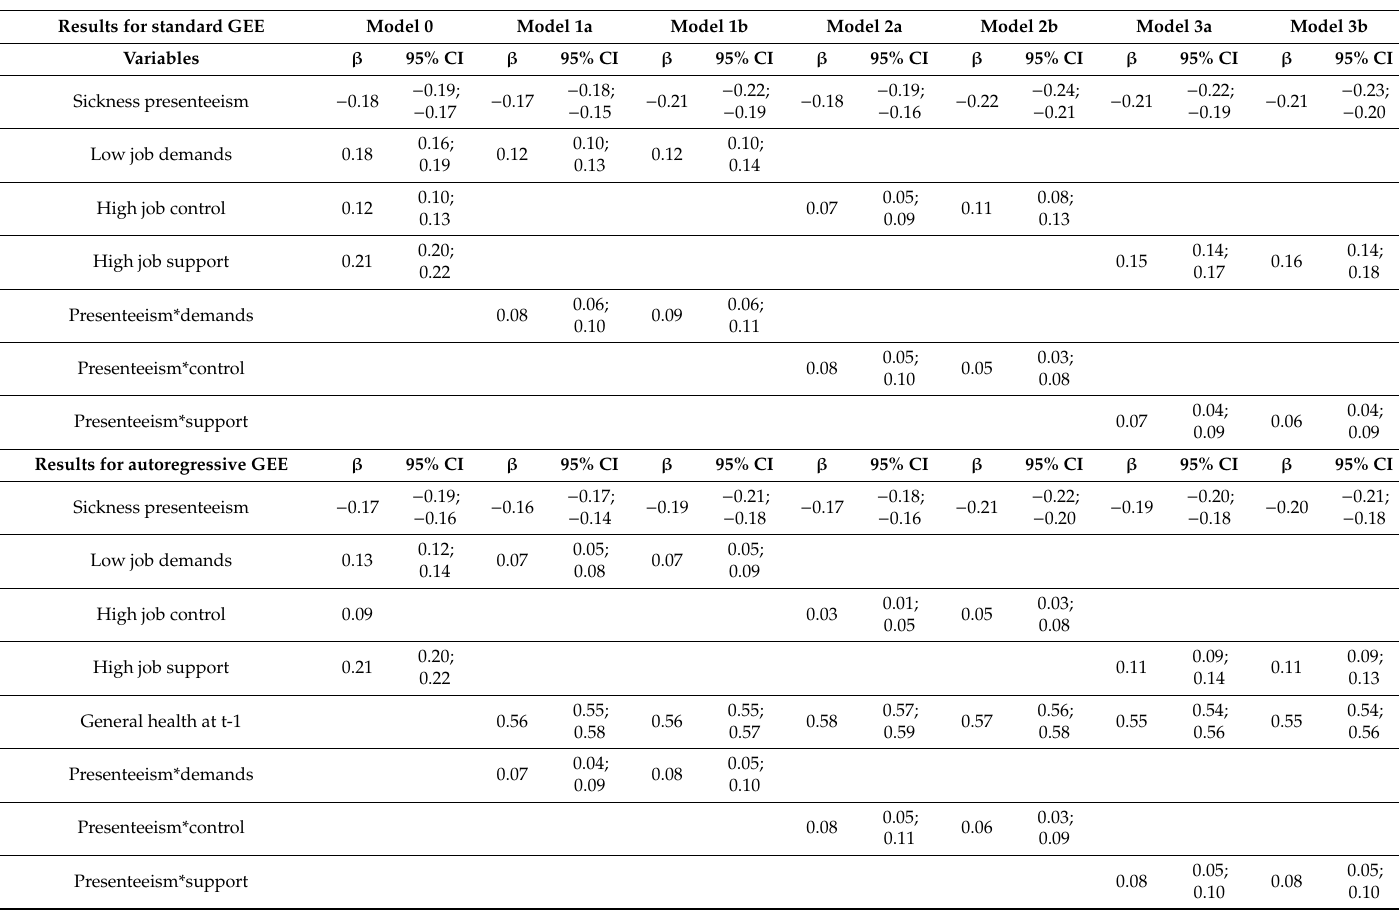
Table 2. Results of standard and autoregressive generalized estimating equations (GEE) analyses of the association between sickness presenteeism (1 = sickness presenteeism of ≥ 1 day during the past 12 months) and general health, presented as beta estimates ( β ) with 95% CIs, taking job demands, job control and job support as possible moderating job characteristics into